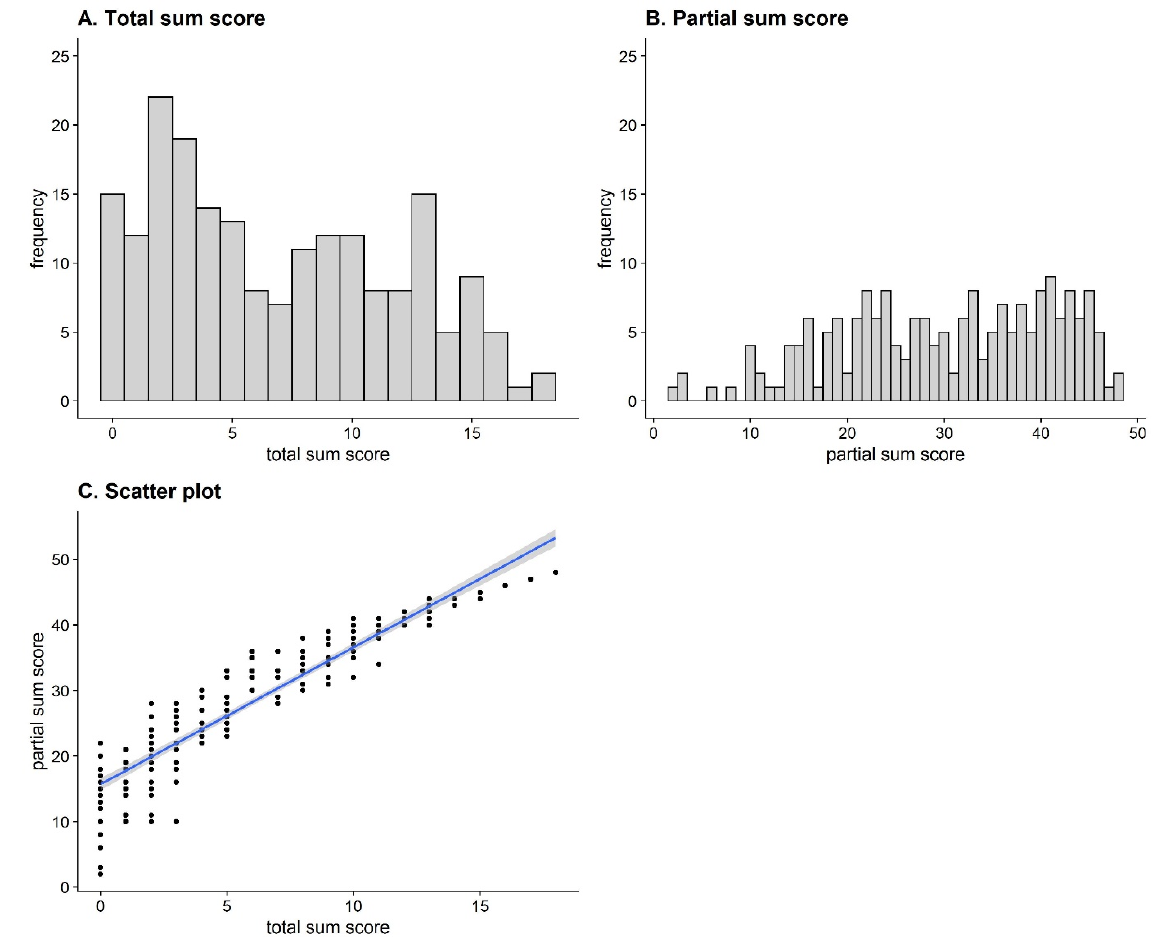
Figure 3. Histogram of total sum scores ( A ), histogram of partial sum scores ( B ) and scatterplot for the relationship between the total and partial sum scores ( C ).